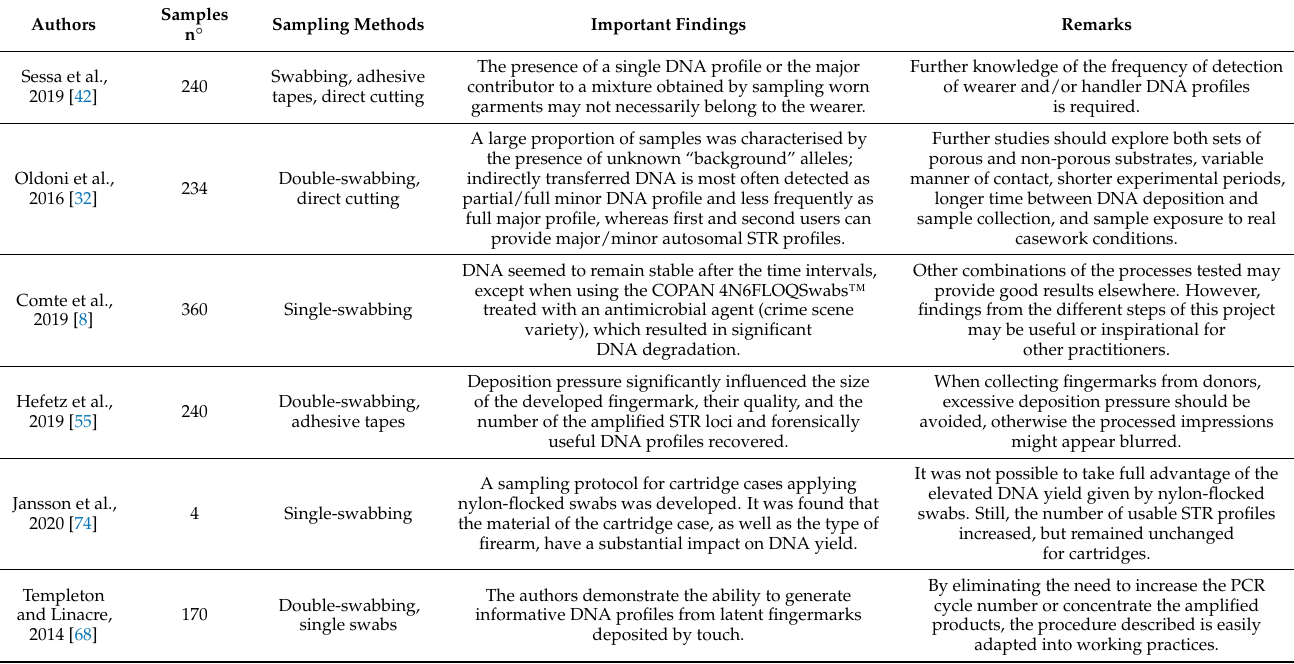
Table 3. Papers categorized in Group 3a. Features displayed are authors and publication year, num- ber (n°) of samples collected, sampling methods implemented, important findings, and remarks highlighted. N.A. not assigned.